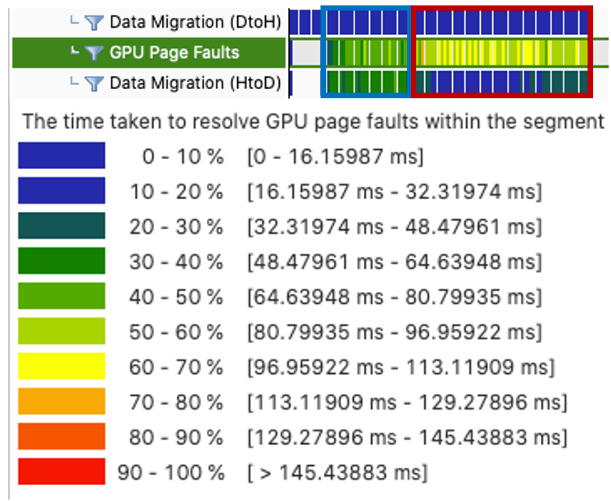
Figure 11. GPU page fault pattern in single mini-batch